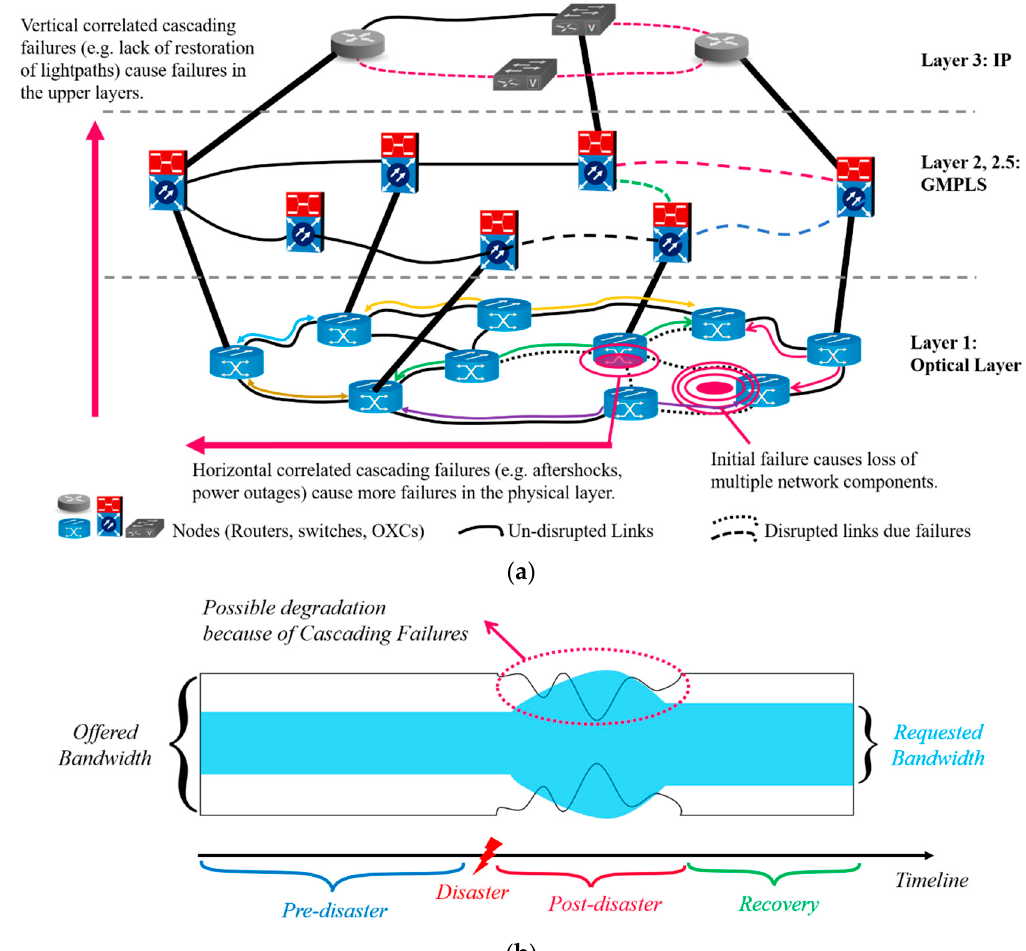
Figure 3. Effects of Correlated Cascading Failures. ( a ) Horizontal and Vertical Correlated Cascading Failures; and ( b ) Pre-Disaster and Post-Disaster Typical Requested and Offered Bandwidths.